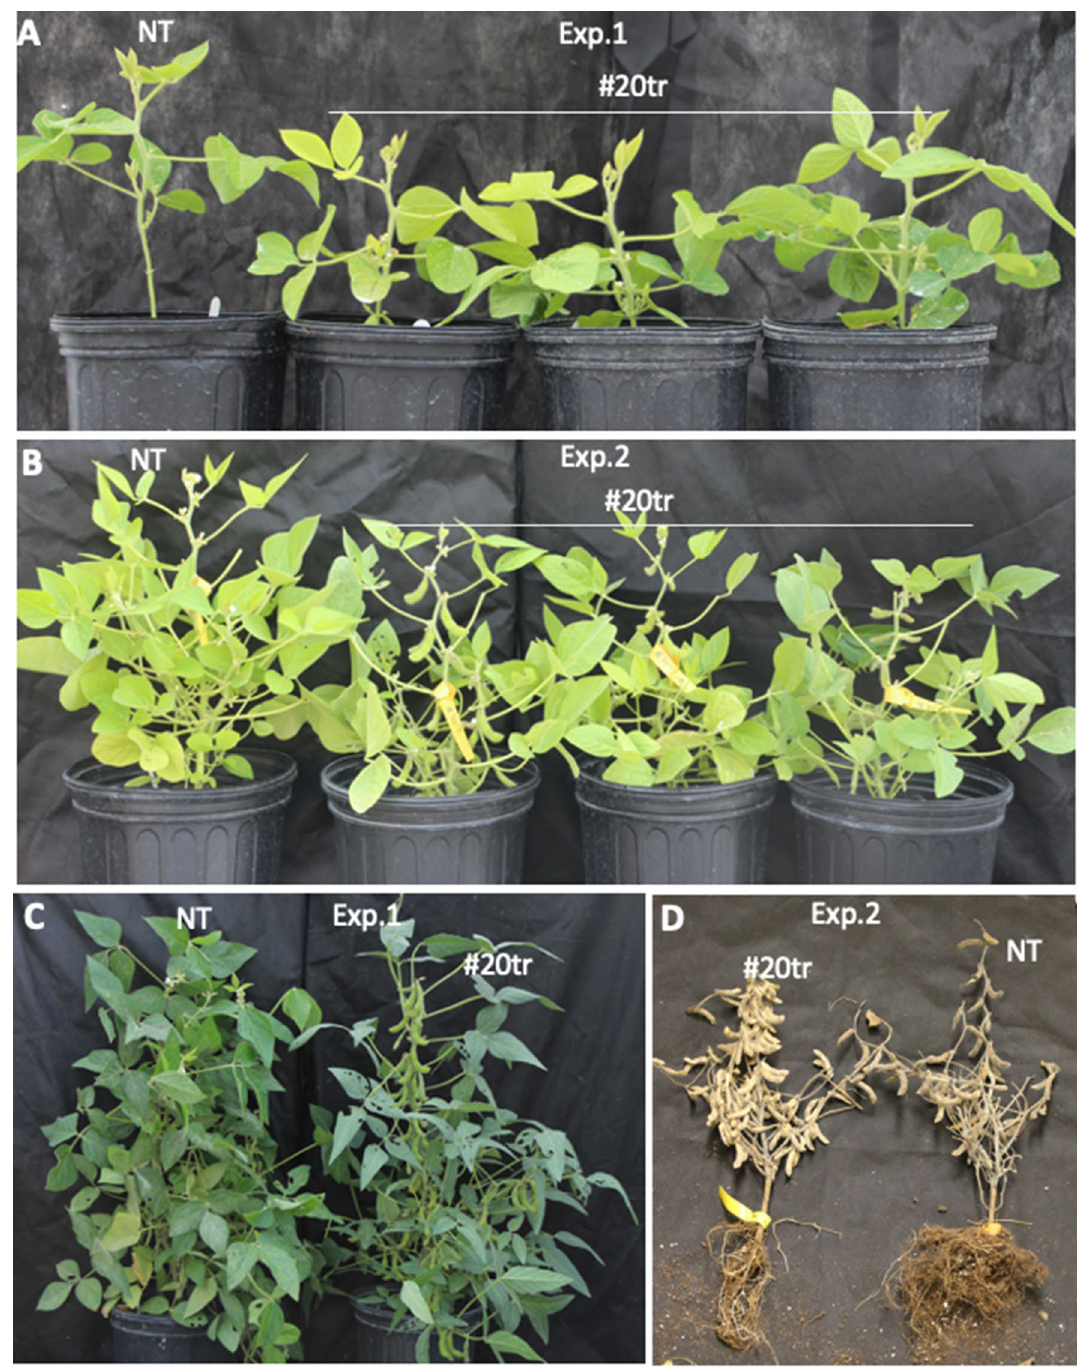
Figure 3. Growth of nontransgenic (NT) and transgenic soybean plants from a representative, T 1 transgenic (TR) line expressing the ZmSOC1 . All the plants were grown under natural environmental conditions. ( A ) Flowering of the 35-day old plants in the experiment #1. ( B ) Pod formation in the 67-day old plants in the experiment #2. ( C ) Seed pod production in the 134-day old plants in the experiment #1. ( D ) Seed pod production in the harvested plants in the experiment